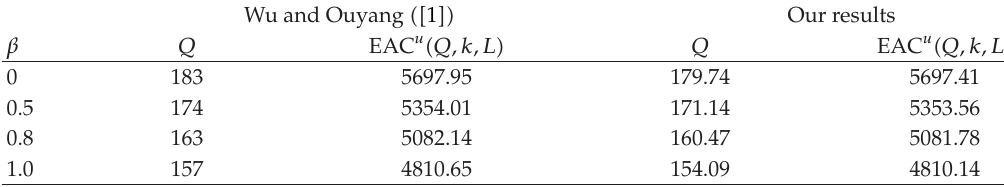
Table 3: The comparison between Wu and Ouyang (cid:4) 1 (cid:5) and ours. Wu and Ouyang (cid:2)(cid:4) 1 (cid:5)(cid:3) Our results β